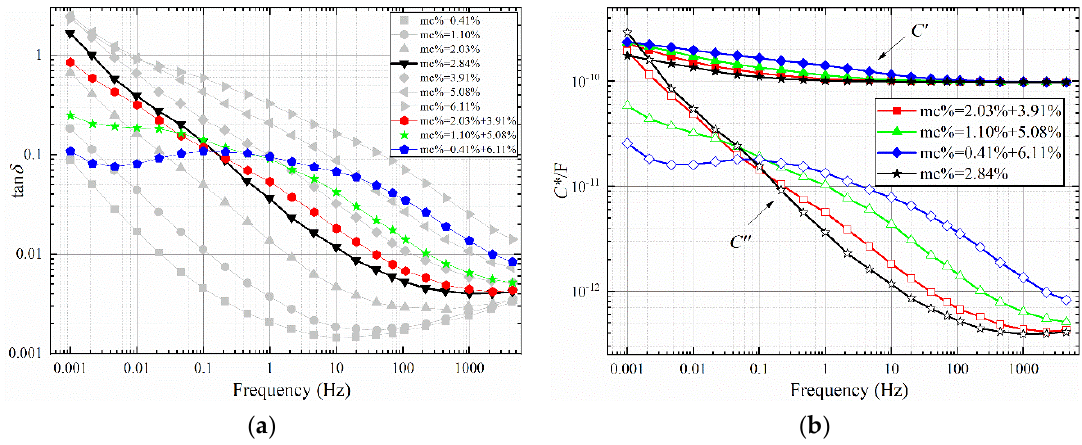
Figure 7. FDS characteristic curve with an average water content of 3%. ( a ) tan δ - f , ( b ) C *- f .